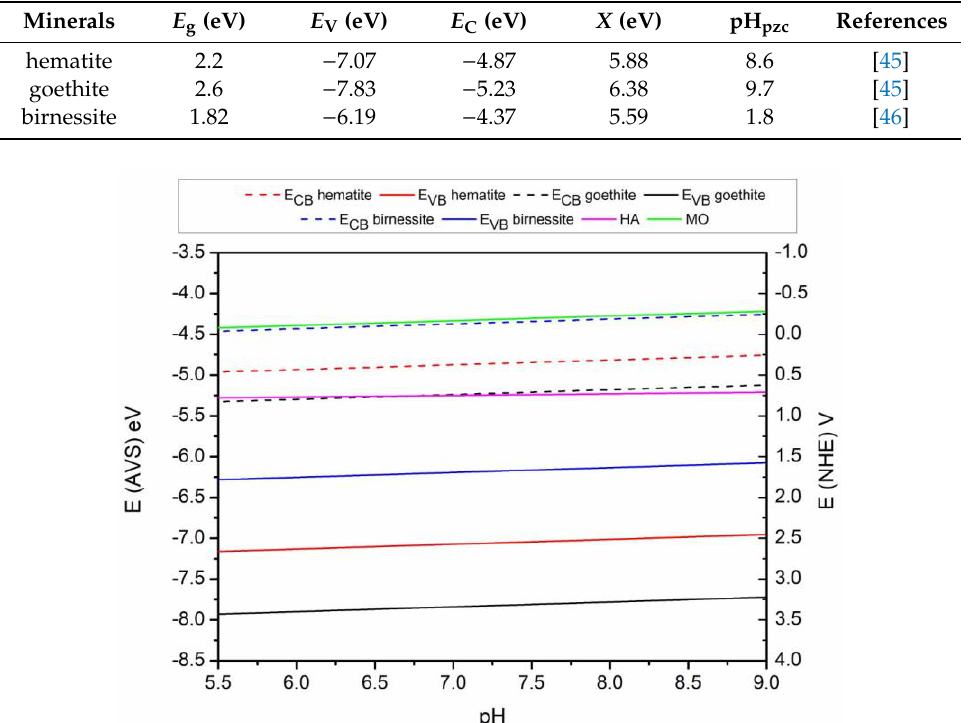
Table 2. Absolute electronegativity ( X ), band gap ( E g ) and band edge position ( E v and E c ) of hematite, goethite and birnessite in an AVS (absolute vacuum scale) scale at pH 7.